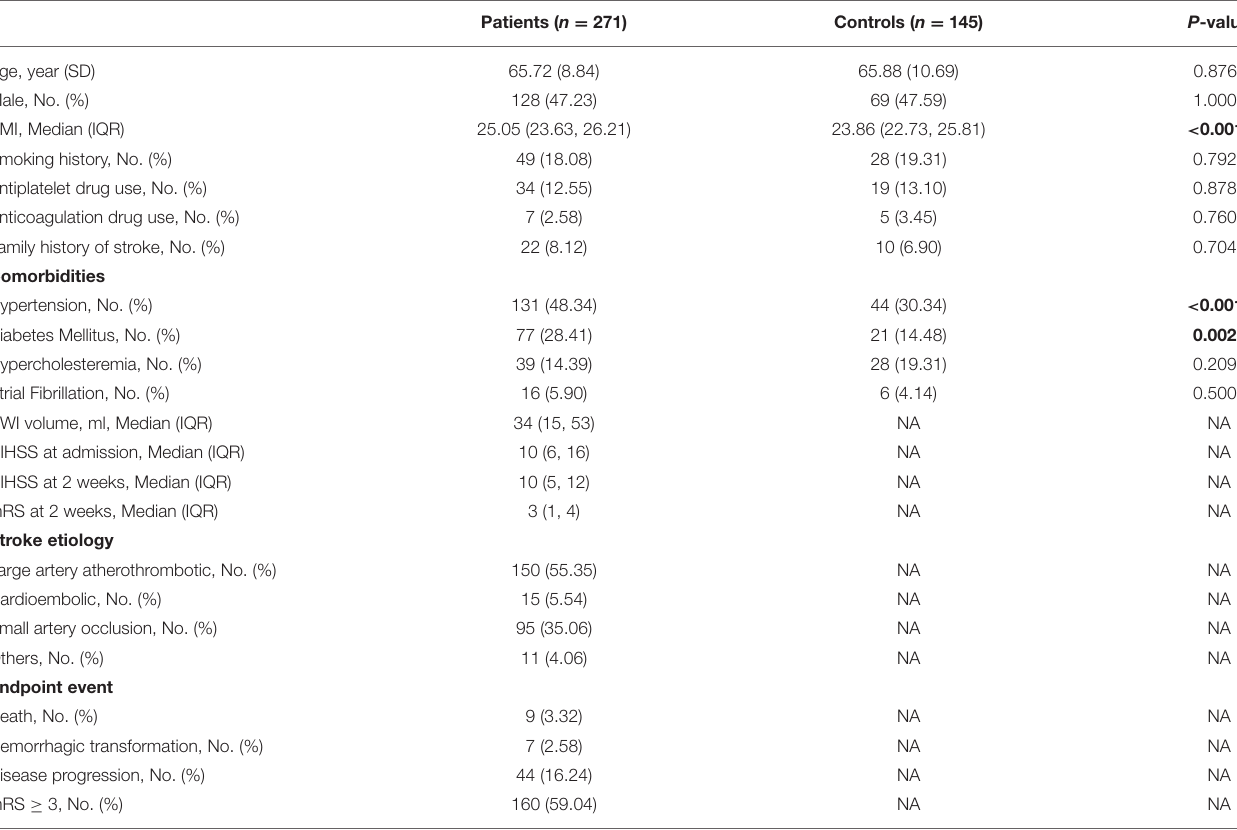
TABLE 1 | Demographic data of subjects.